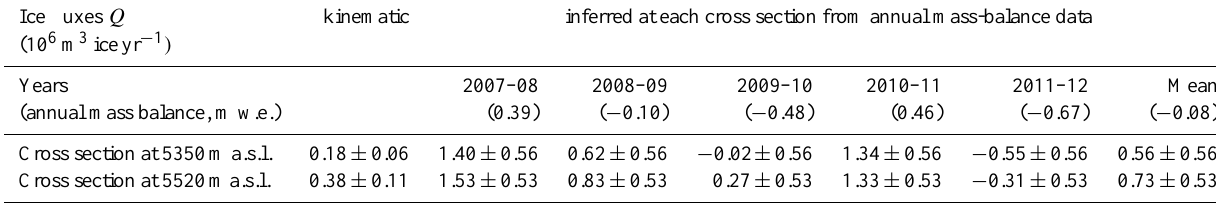
Table 3. Ice fluxes Q (10 6 m 3 iceyr − 1 ) , inferred from the kinematic method and from the annual mass balance data at each cross section surveyed in the field, i.e. at mean elevations of 5350ma.s.l. and 5520ma.s.l. respectively. For the sake of comparison the glacier-wide annual mass balances for the 5 surveyed years are also given (in parenthesis). inferred at each cross section from annual mass-balance data